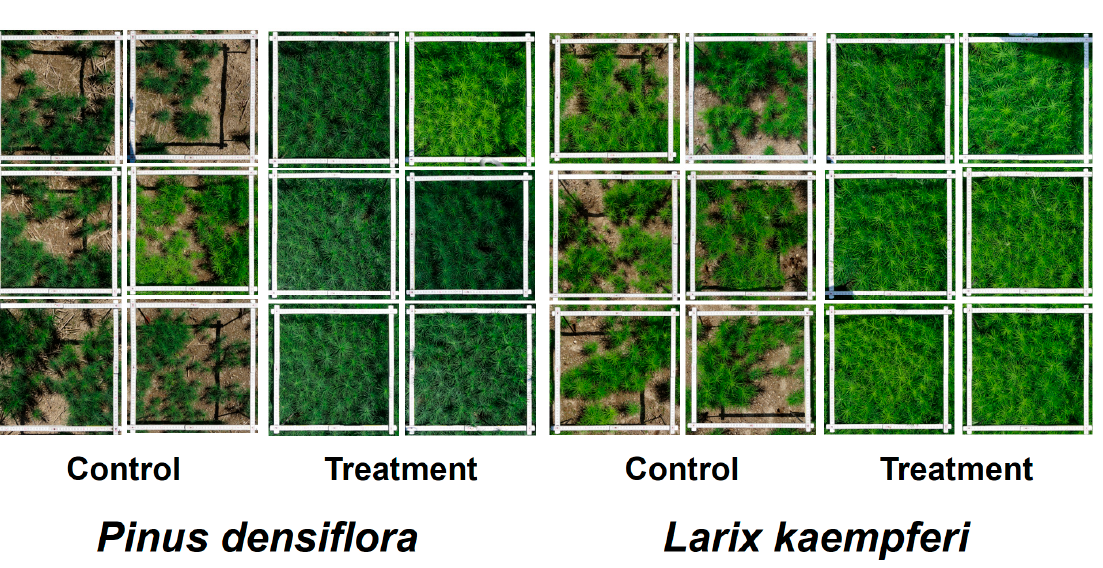
Figure 1. Photographs of pine and larch seedlings in control and soil fumigation treatment plots in the open-field nursery.